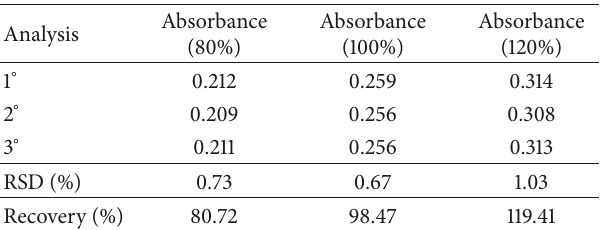
Table 2: Accuracy of the analytical method for the in vitro dissolution of dapagliflozin.